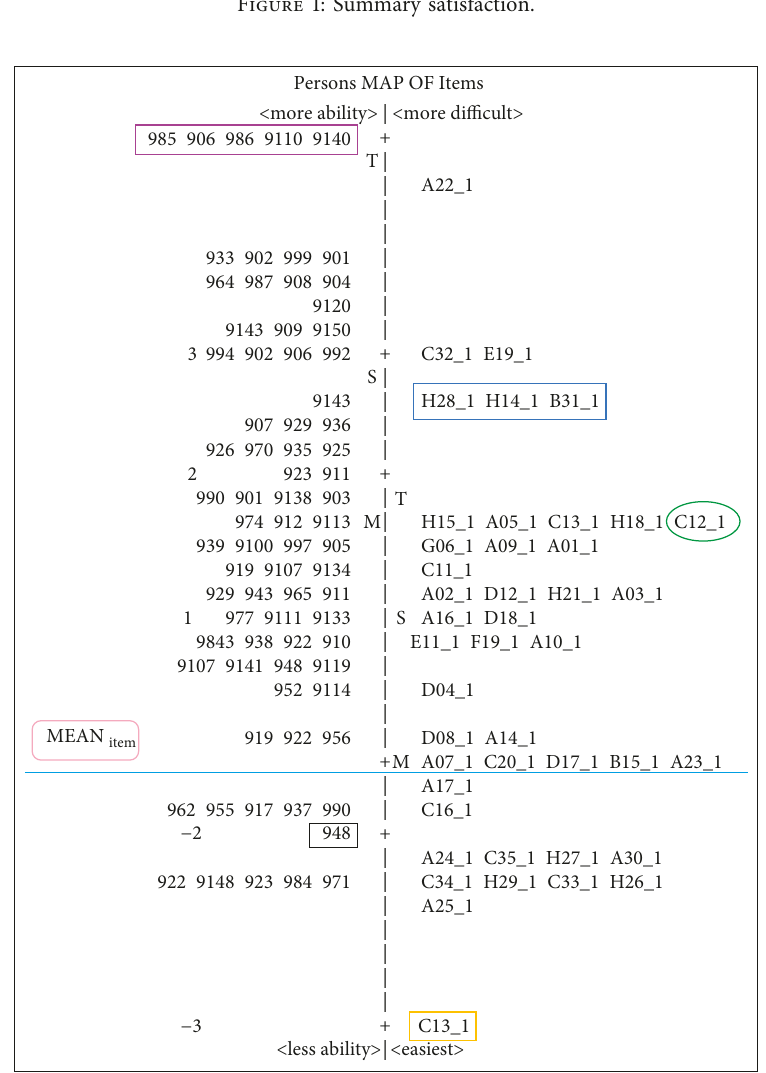
Figure 1: Summary satisfaction.